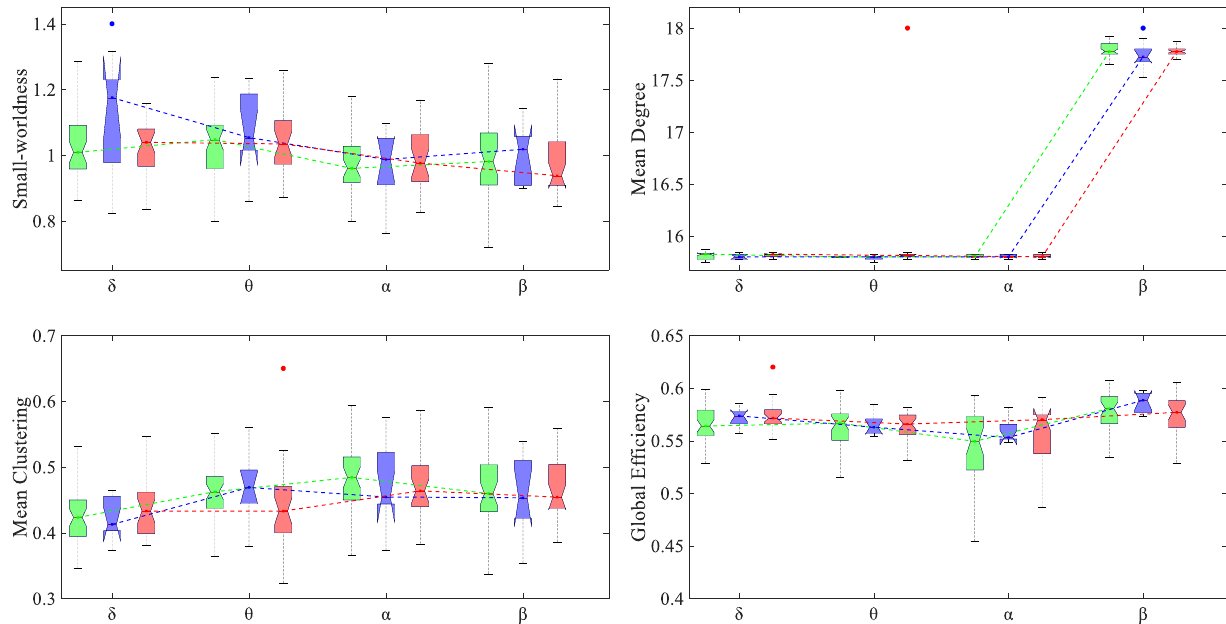
Figure 8. Average global graph measures for each group (TD: green; ADHD I : blue; ADHD C : red) in different frequency bands. The blue and red points indicate statistically significant differences ( p < 0.05, non-parametric permutation) between the ADHD I and TD groups and between the ADHD C and TD groups, respectively.